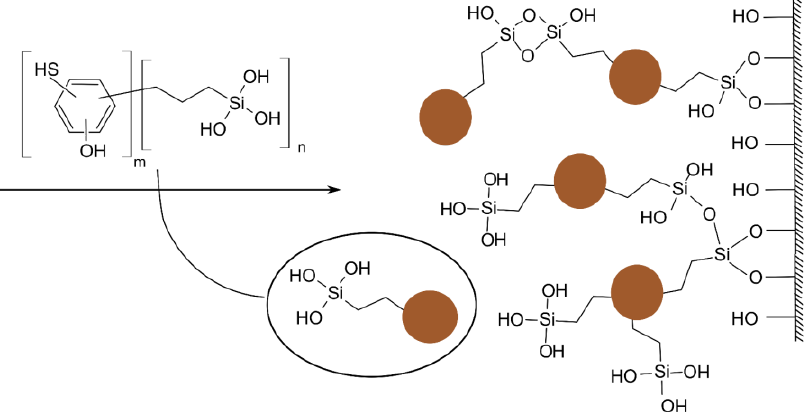
Figure 7. Schematic interaction of the silanol-rich modified HS with Si-OH-carrying solid phase.